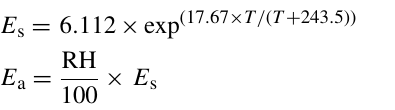
were derived by averaging daily values in each